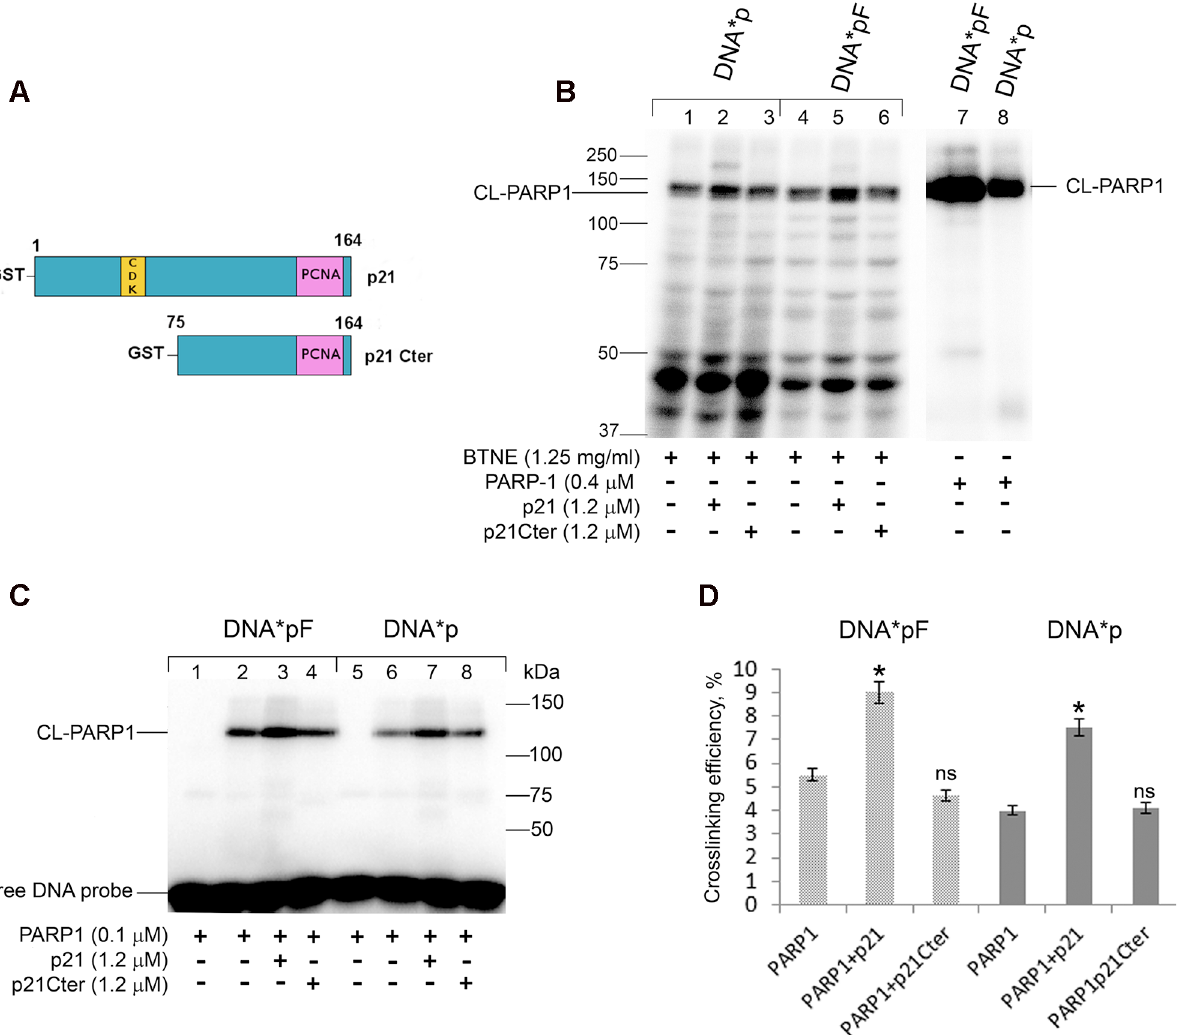
Fig 1. p21 increases the level of PARP-1 crosslinking to nick-containing BER DNA intermediates. ( A ) Schematic diagram showing the structure of p21 full length, with CDK and PCNA binding domains, and of the C terminal fragment (p21 Cter) lacking the first N-terminal 74 aa. ( B ) Crosslinking of PARP1 of the nuclear extract in the presence of p21 or p21Cter. [ 32 P]-labeled 0.1 μ M DNA * pF (lanes 1 – 3, 7) or DNA * p (lanes 4 – 6, 8) was incubated with bovine testis nuclear extract (BTNE) proteins (lanes 1 – 3, 4 – 6) in the presence of 1.2 μ M p21 (lanes 2, 5) or p21Cter (lanes 3, 6). Loading control: DNA * pF, and DNA * p incubated with recombinant PARP-1 (lanes 7, 8). ( C ) Crosslinking of recombinant PARP1 in the presence of p21 or p21Cter. [ 32 P]-labeled 0.1 μ M DNA * pF (lanes 1 – 4) or DNA * p (lanes 5 – 8) was incubated with recombinant PARP-1 in the presence of p21 (lanes 3, 7) or p21Cter (lanes 4, 8). Then the mixtures were UV irradiated (lanes 2 – 4 and 6 – 8). Free DNA probe is also shown. The products were separated on 10% SDS-PAGE and analyzed by PhosphorImaging. The reaction conditions and analysis of the reaction products are described in “ Materials and Methods ” . The nucleotide sequence and structure of (DNA * pF and DNA * p) is reported (Table 1). ( D ) Diagram showing the quantitative analysis results shown in panel C. The crosslinking of PARP-1 was defined as the percentage (%) of photoreactive DNA, which formed covalent adducts with PARP-1. Error bars represent relative mean ± SD, n = 4. Asterisks denote statistically significant difference ( * , P < 0.05, ns, not significant; t-test).